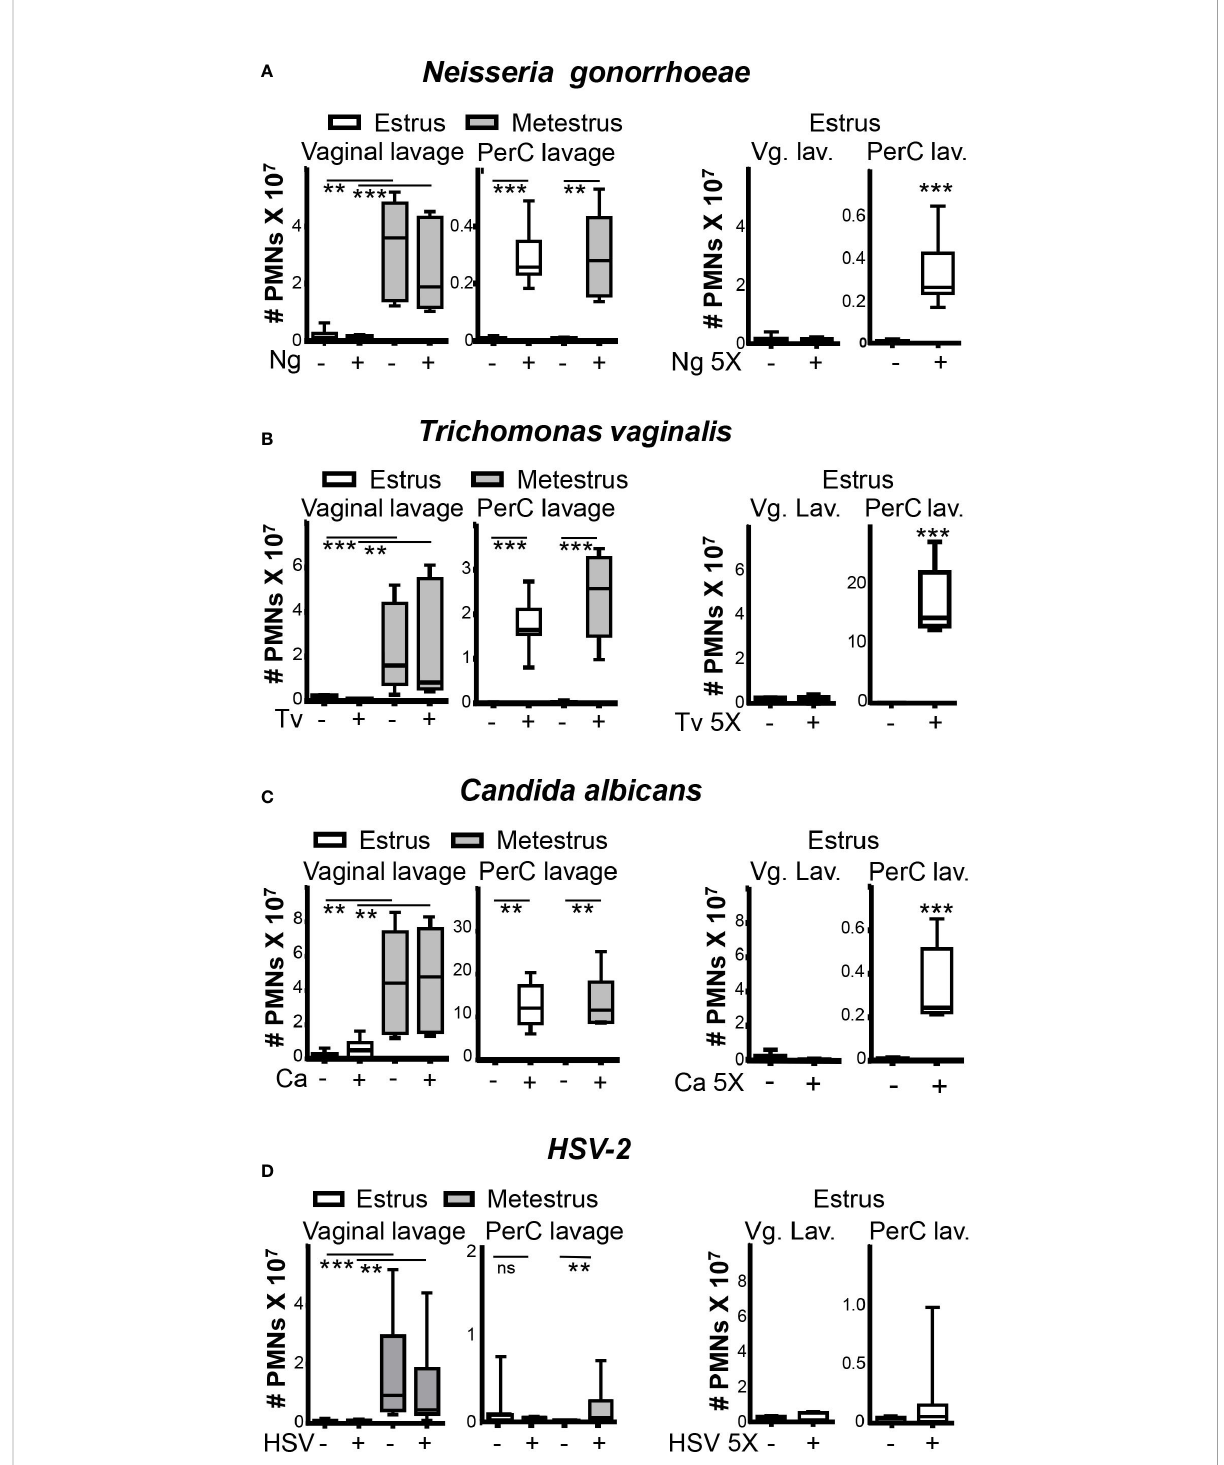
FIGURE 2 Neutrophils in the vaginal lumen and peritoneal cavity after pathogens challenge. Adult female mice were selected by vaginal smear and challenged in the vagina or peritoneal cavity with (A) Neisseria gonorrhoeae , (B) Trichomonas vaginalis , (C) Candida albicans and (D) HSV-2. Number of neutrophils was analyzed by fl ow cytometry. Data were calculated in at least 3 experiments (n=8 mice per group) and expressed as box and whiskers 10-90 percentile. **p < 0.01 and ***p < 0.001, Mann-Whitney test. PerC, peritoneal cavity; Vg. Lav, Vaginal lavage; Ng, Neisseria gonorrhoeae ; Tv, Trichomonas vaginalis and Ca, Candida albicans . ns, non signi fi